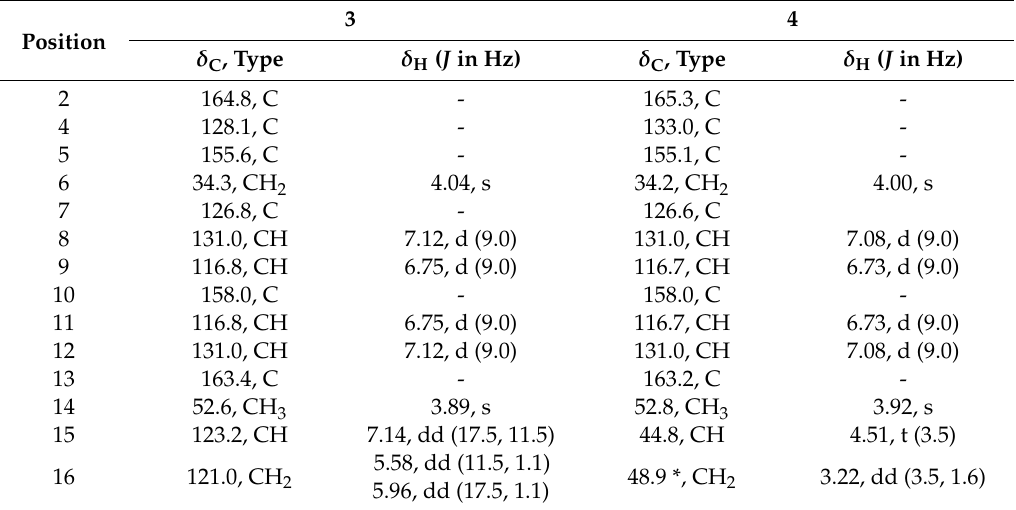
Table 3. 13 C and 1 H-NMR spectroscopic data ( 1 H 500 MH Z , 13 C 125 MH Z in Methanol- d 4 , δ in ppm) for compounds 3 and 4